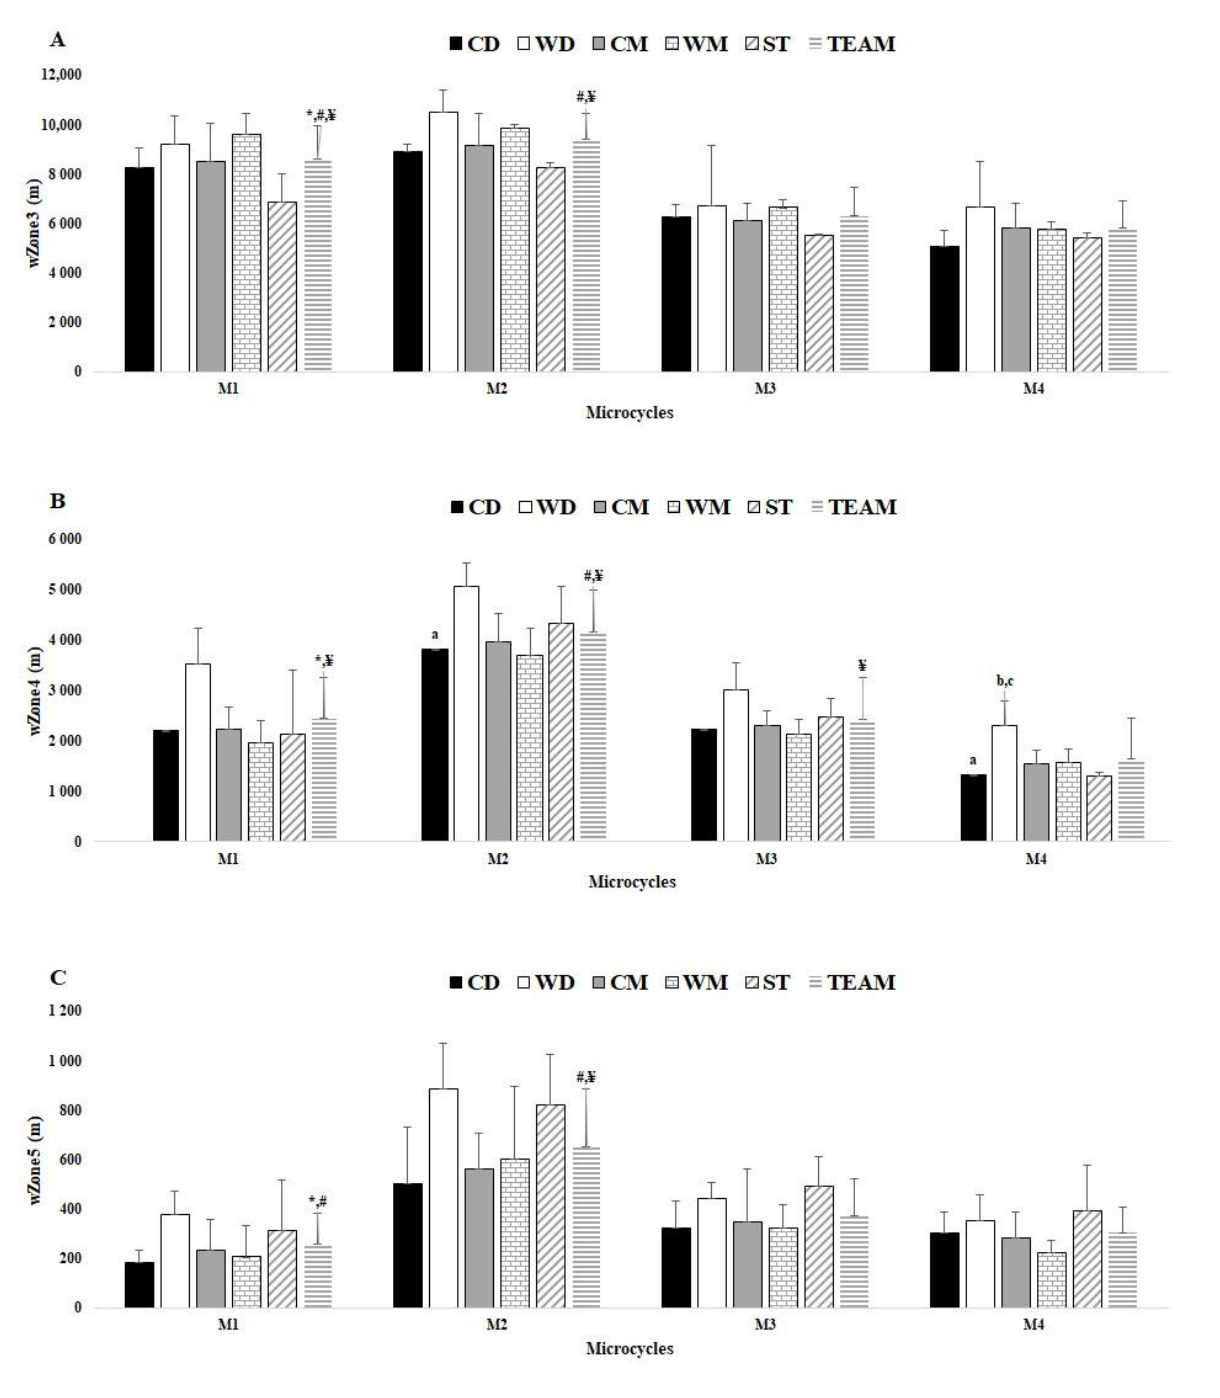
Figure 2. Comparisons between player positions for weekly Zones 3, 4, and 5 for each microcycle, (e.g., M1, M2, M3, and M4) and between Ms by team average. ( A ) wZone3; ( B ) wZone4; ( C ) wZone5; a denotes difference from WD, b denotes difference from WM, c denotes difference from ST, * denotes difference from M2, # denotes difference from M3, ¥ denotes difference from M4, all p < 0.05. 3.3. Comparisons between Player Positions There were no differences between playing positions for all Ms and variables, except for Zone 4, which displayed some difference between playing positions, namely CD vs. WD (ES = − 4.83) in M2 and M4 (ES = 4.96). Additionally, WD vs. WM (ES = − 5.88) and WD vs. ST (ES = 5.38) in M4 (Figure